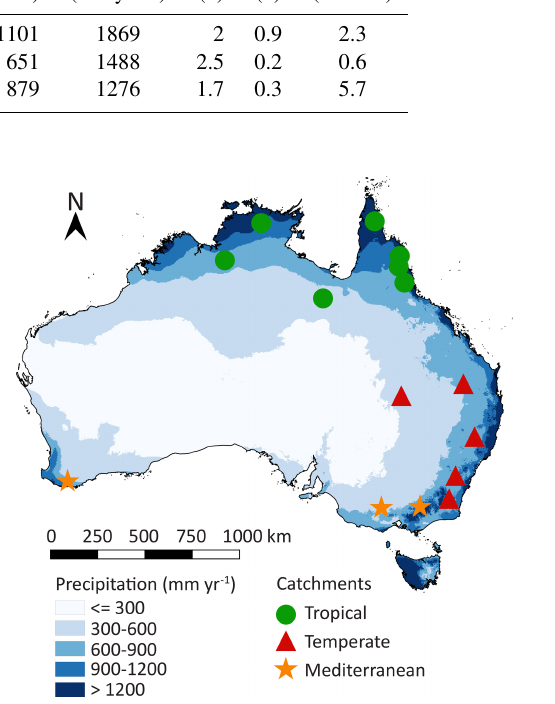
Figure 1. Location of the 15 study catchments within Australia. The green, red and orange markers indicate the climate region, and the blue shades indicate long-term mean annual precipitation (Aus- tralian Government Bureau of Meteorology, 2019). A list of the catchments and their characteristics is provided in Table